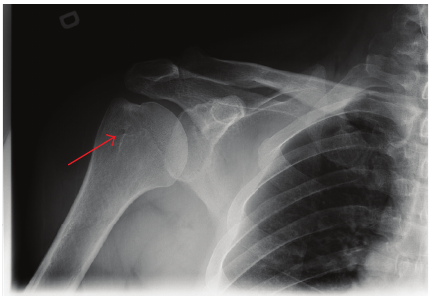
Figure 1: Plain radiograph of right shoulder showing small degener- ative cysts at the site of insertion of the supraspinatus tendon on the greater tuberosity (arrow), indicative of rotator cuff tendinopathy.